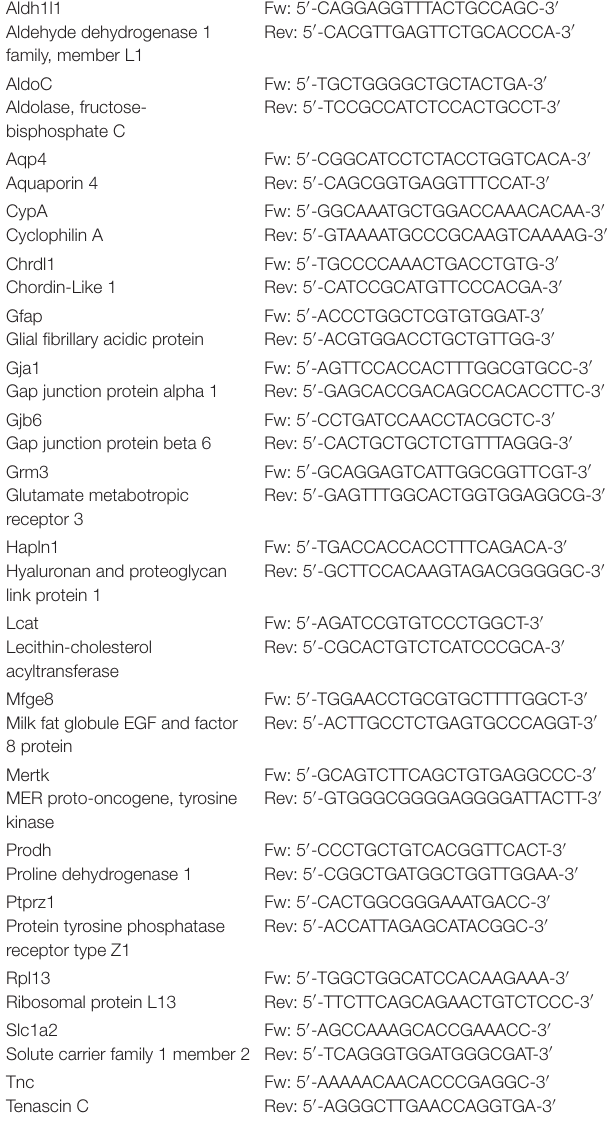
TABLE 2 | The genes and the primers used for qRT-PCR are